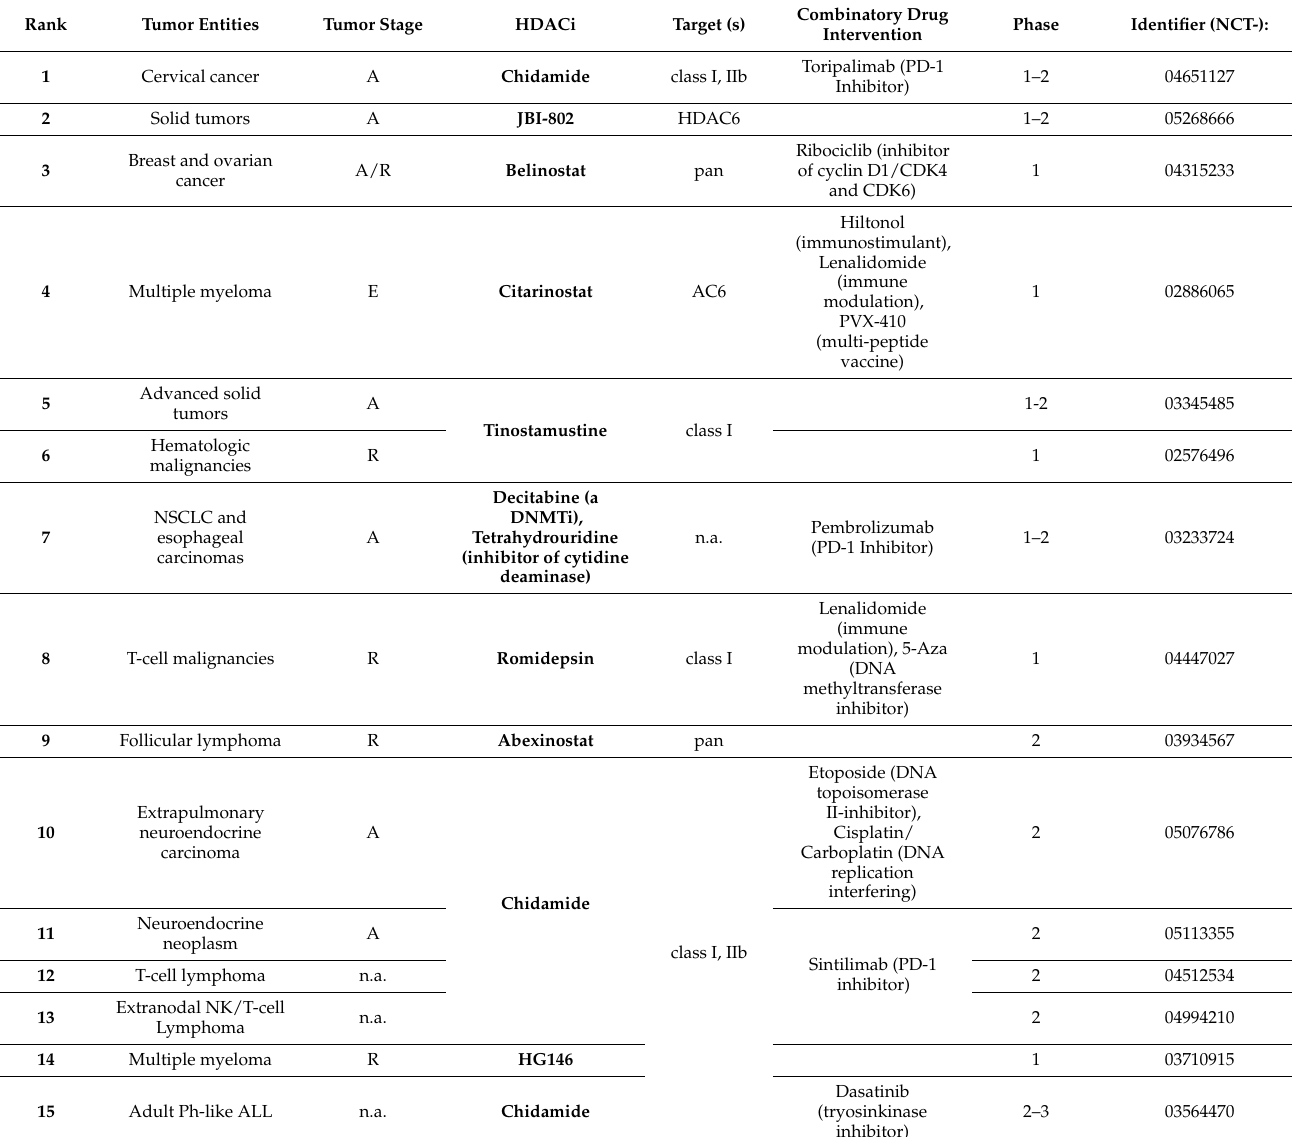
Table 1. Recruiting clinical trials dealing with HDAC inhibitors and malignant disease (regarding the terms “HDAC” and “malignancy” in the clinical trial data database of the NIH, see https:// clinicaltrials.gov (accessed on 12 August 2022); clinical trial #7 does not apply an HDAC-inhibitor, but include the term HDAC in the list of keywords. Abbreviations: 5-Aza = 5-Azacitidine, A = advanced, DNMTi = DNA methyltransferase inhibitor, E = early, n.a. = not applicable, NSCLC = non-small cell lung cancer, R =